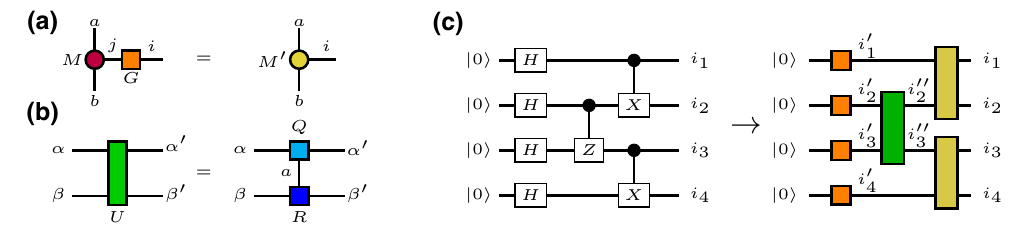
FIG. 13. Tensor networks and quantum circuits. (a) Contraction of a three-index tensor M with a one-qubit gate G . (b) QR decomposition of a two-qubit gate U . (c) From a quantum circuit to its tensor network